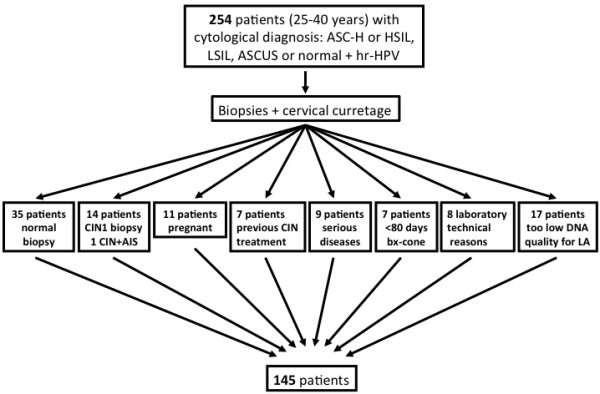
Inclusion and exclusion criteria. Norwegian guidelines for histological examination of atypical cytology were followed: 1. Low grade Squamous Intraepithelial Lesion (LSIL) + high-risk Human Papillomavirus (hr-HPV) or 2. Atypical Squamous Cells of Undetermined Significance (ASCUS) + hr-HPV or 3. Recurrences of hr-HPV positive cervical smears or 4. Atypical Squamous Cells, cannot rule out a High Grade lesion (ASC-H) or 5. High Grade Squamous Intrepithelial Lesion (HSIL). AIS denotes Adenocarcinoma in situ and Bx Biopsy